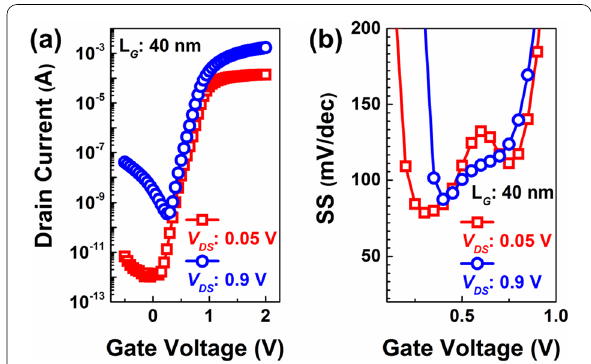
Fig. 2 ( a ) Transfer curves of the device with L G ( b ) Extracted SSs as a function of the V GS of the